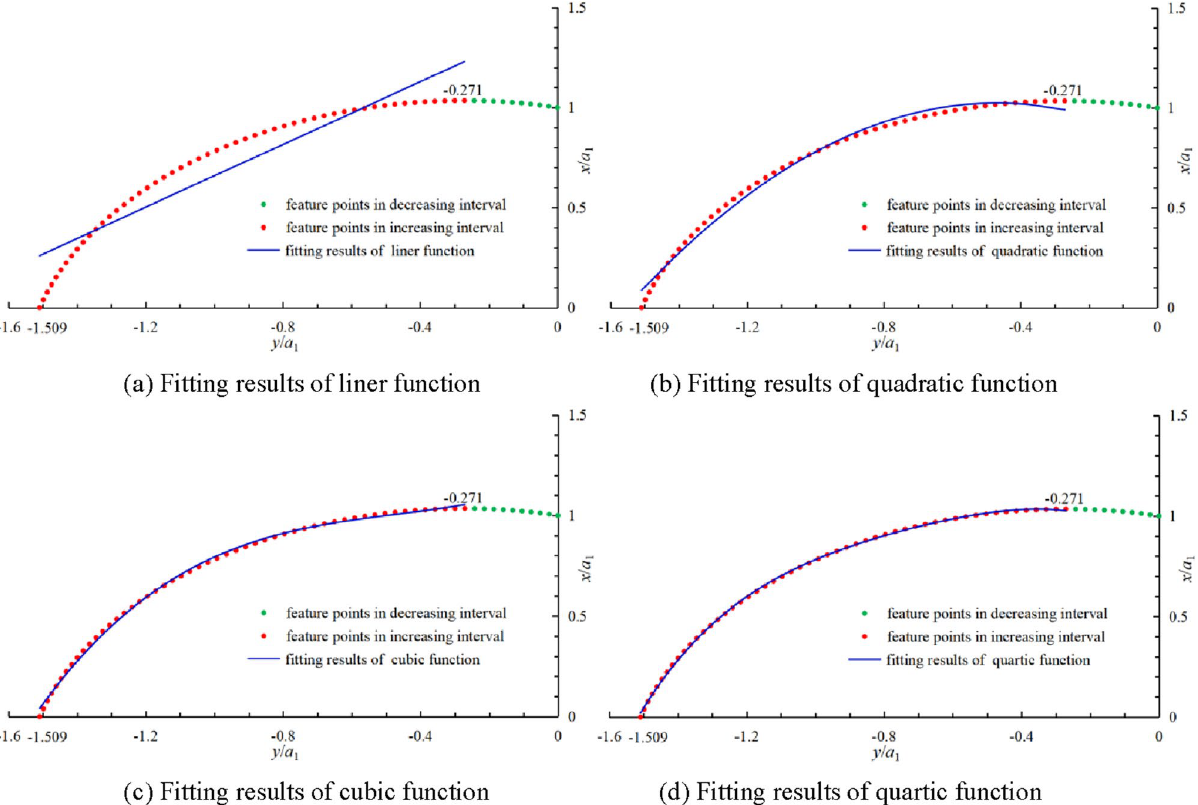
Figure 3. Least square fitting